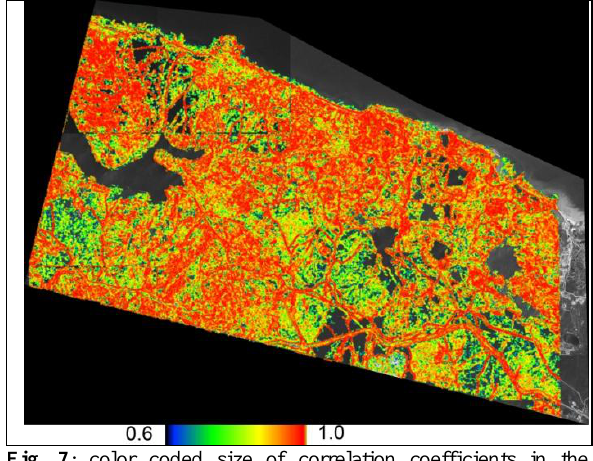
the correlation coefficient threshold to